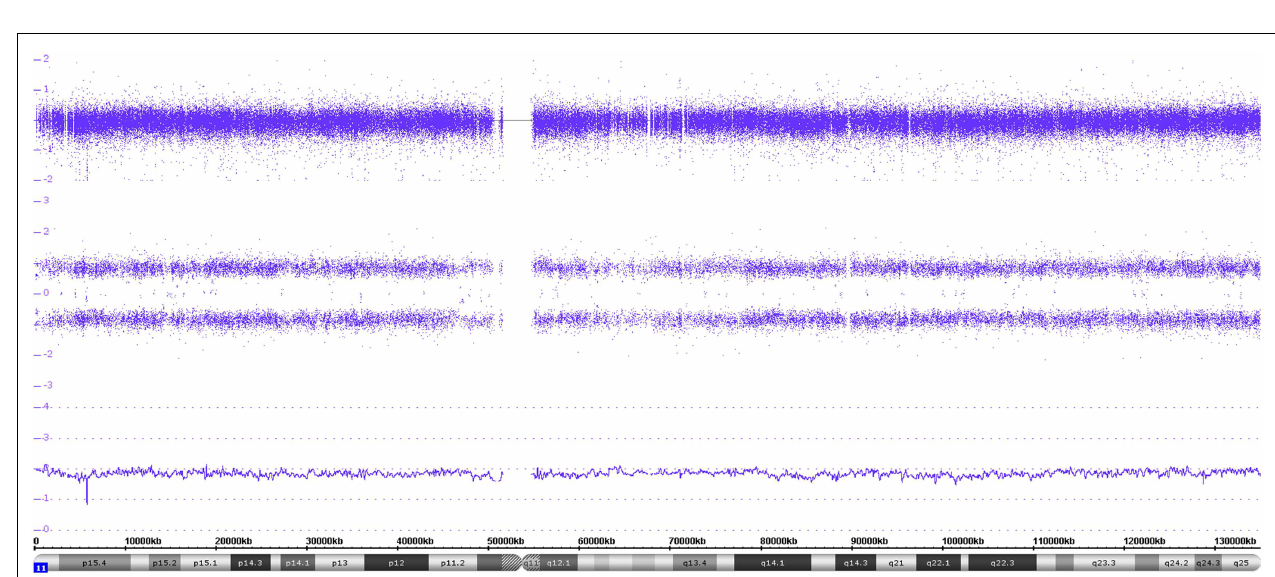
FIGURE 10 | Gives an example of a whole chromosome uniparental isodisomy . Both the log 2 copy values and the smooth signal indicate two copies of chromosome 11. However, only two allele peak tracks are visible representing the AA and BB